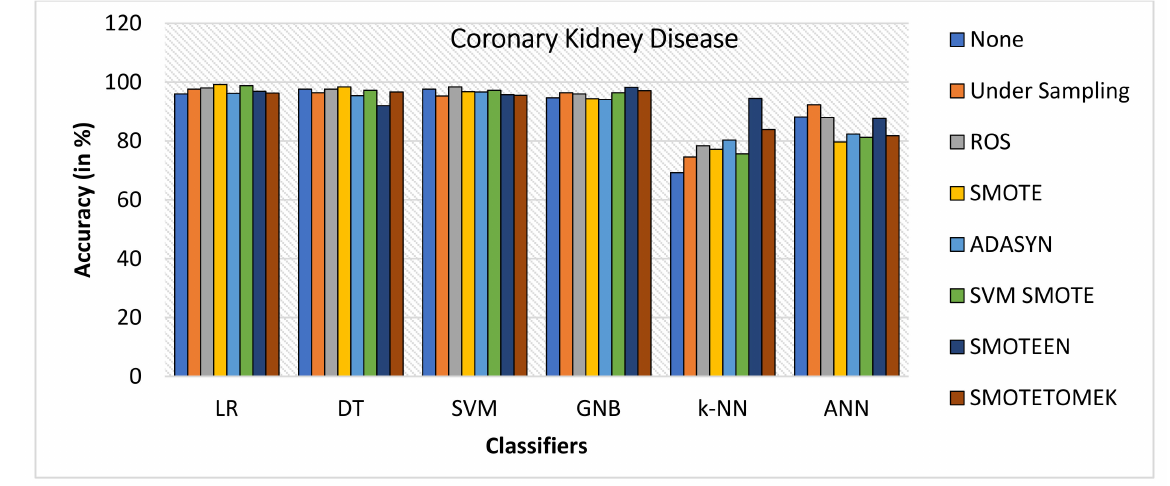
Figure 14. Accuracy for kidney disease dataset of balancing algorithms over six classifiers.